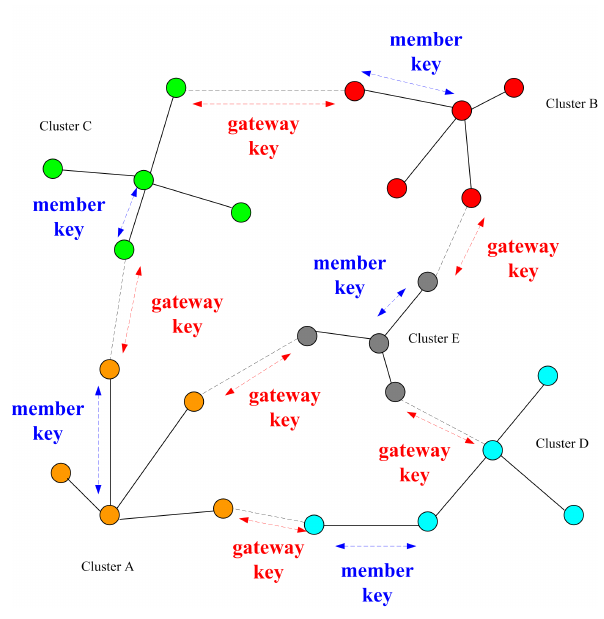
Figure 2. Phase III: Key distribution for